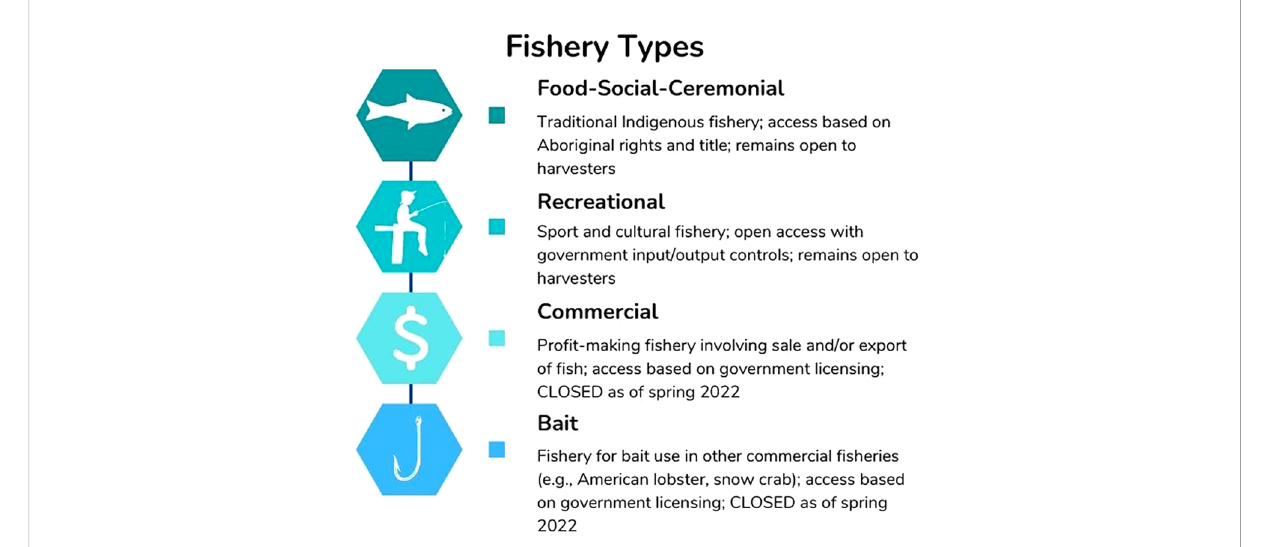
FIGURE 1 Summary of fi shery types targeting Atlantic mackerel or Amalamaq ( Scomber scombrus ) in Atlantic